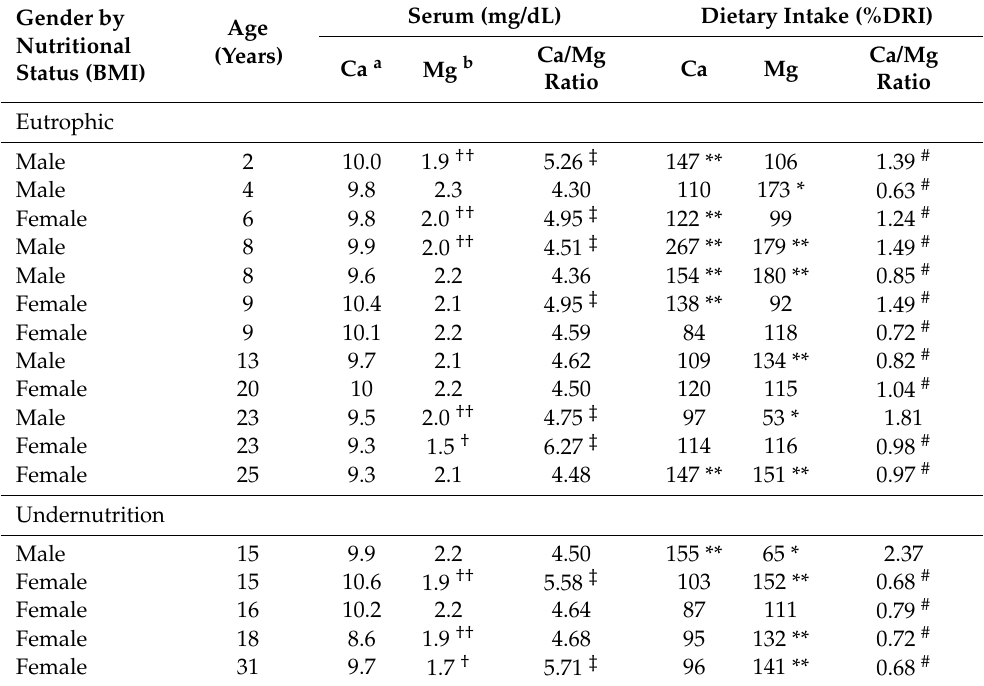
Table 2. Serum levels, dietary intake, and proportions of calcium and magnesium in patients with cystic fibrosis according to nutritional status ( n = 17 *).